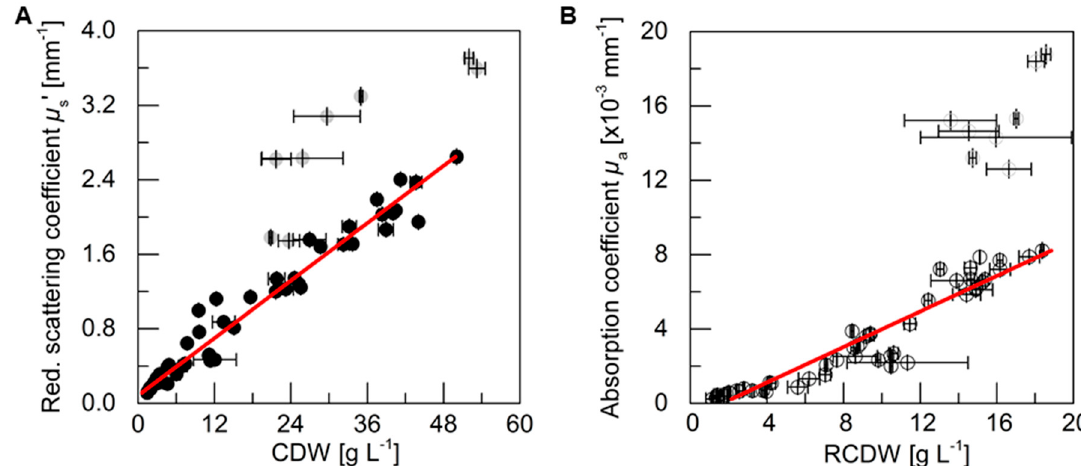
Figure 4. Correlation analysis of PDW spectroscopy signals with off-line values. A) Reduced scattering coefficient µ s ’ at 638 nm is correlated with CDW. B) Absorption coefficient µ a at 638 nm is correlated with RCDW. Data points are from five cultivations with different rapeseed oil and urea contents (cf. Figures 2 and 3). The gray data points comprise the last four samples of the two pulse-based fed-batch experiments (cf. Figure 3), which differ significantly from the other samples and were therefore not considered for the linear fit with the experimental data. A squared correlation coefficient R 2 of 0.96 was obtained for µ s ’ and CDW and R 2 of 0.90 for µ a and RCDW. Error bars indicate minimum and maximum values of technical duplicates (CDW, RCDW). STDEV of the 10-point average is shown for µ s ’ and µ a .